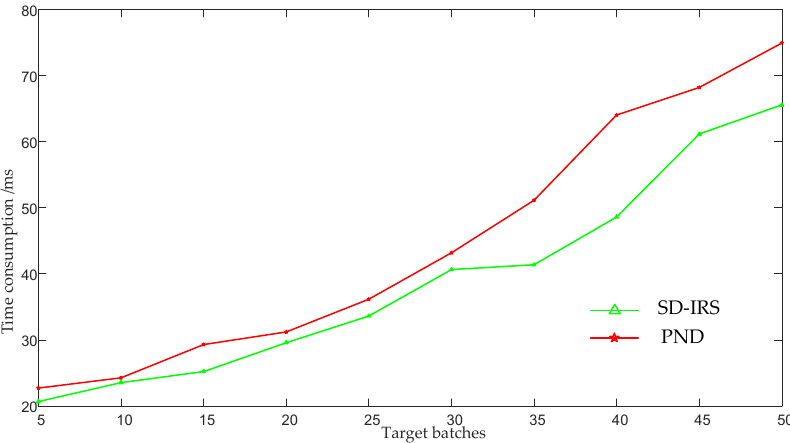
Figure 6. Comparison of time consumption of different algorithms.